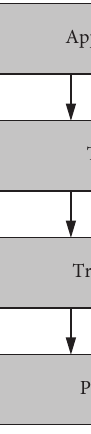
Figure 2: Hierarchical model of CAN